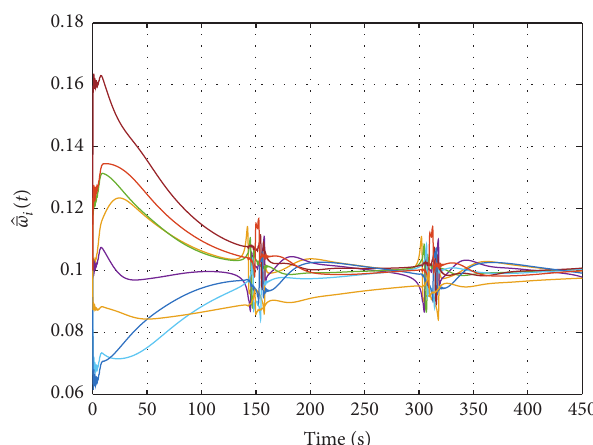
Figure 8: The estimation of upper bound disturbances 􏽢 δ